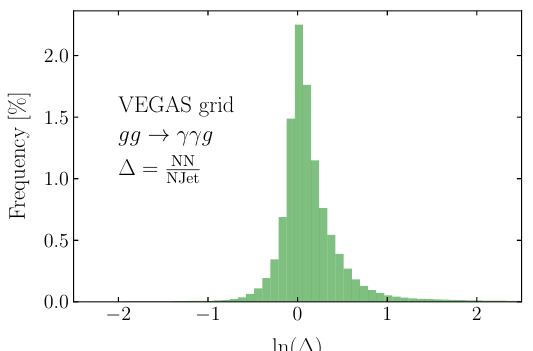
Figure 6. NN/ NJet errors for the 2 → 3 scattering process using a VEGAS optimised integra- tion